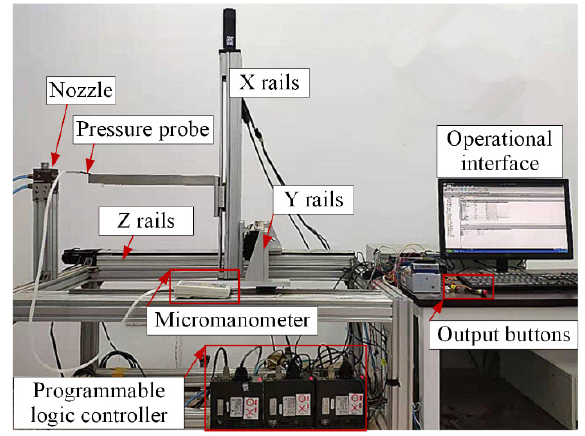
Figure 10. Experimental test system.